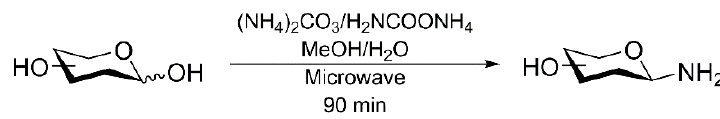
Scheme 1. Protecting group free and microwave-assisted synthesis route for amination of free saccharides according to Kochetkov and Likhoshertov in methanol or water with a 5-fold excess of ammonium salt.